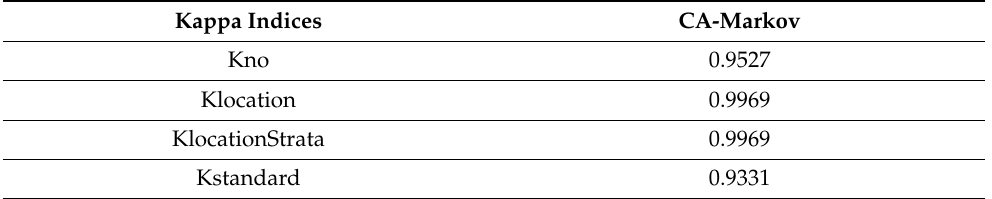
Table 10. Result of Kappa index for model validation.